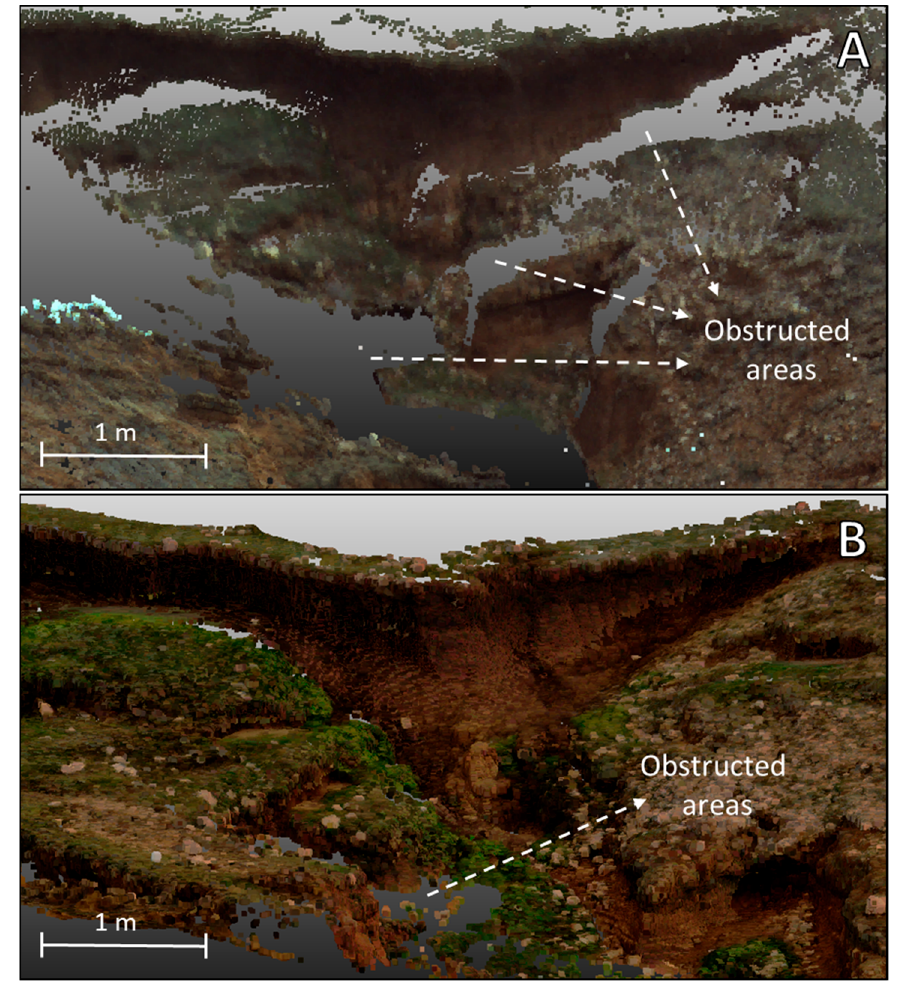
Figure 14. Visual comparison between point clouds covering identical part of gully headcut (( A )—point cloud created by traditional non-systematic approach; ( B )—point cloud created through developed optimization framework).